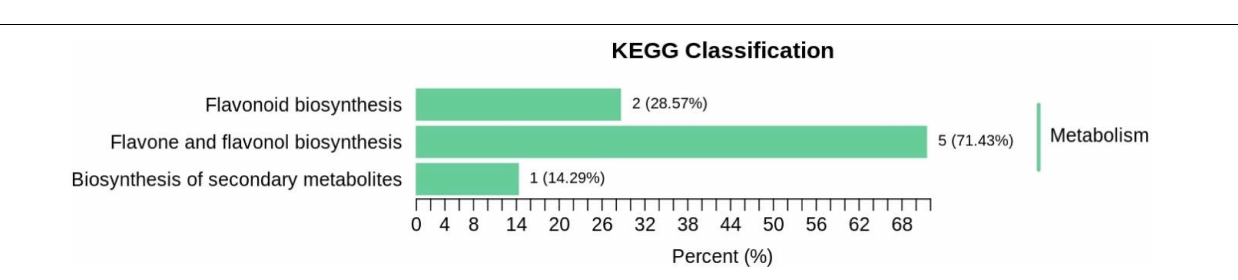
FIGURE 8 | Classification of differential metabolites KEGG in Qssg and Lc